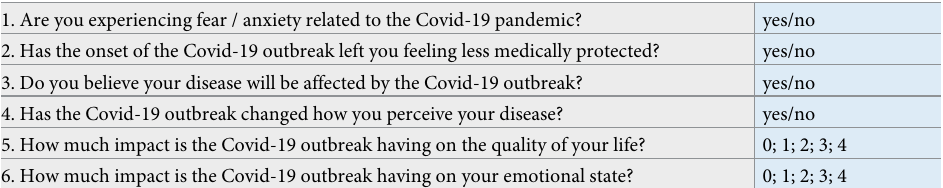
Table 1. The six core components of the Covid-19 Emotional Impact Survey